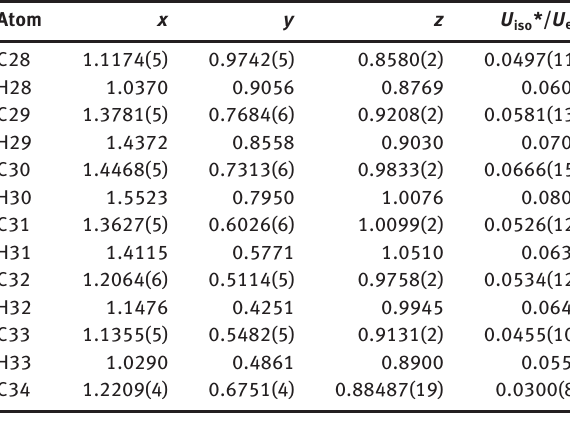
provided by two chlorido ligands and the dppf ligand ( cf . the figure). The average Zn-P bond distance of 2.4113(10) Å is similar to those observed in related complexes [9]. The Zn—Cl bond lengths (mean value 2.2423(10) Å) are not